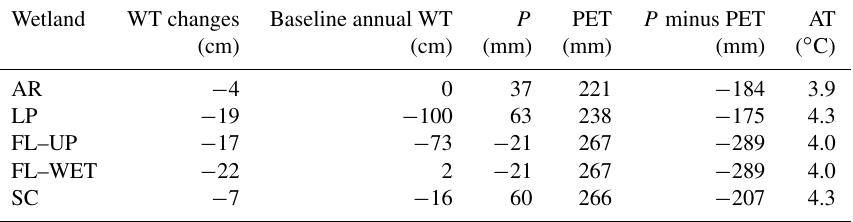
Table 4. Annual changes in variables from the baseline scenario to scenario RCPs 8.5 of five wetlands in the Se United States. Wetland WT changes Baseline annual WT P PET P minus PET AT (cm) (cm) (mm) (mm) (mm) ( ◦ C) AR − 4 0 37 221 − 184 3.9 LP − 19 − 100